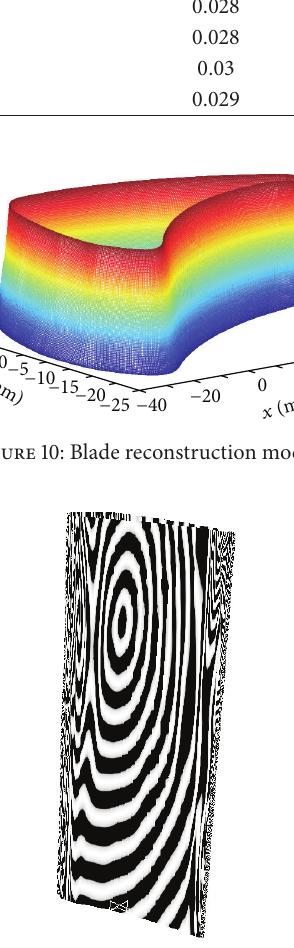
Figure 11: Zebra mapping effect of the blade